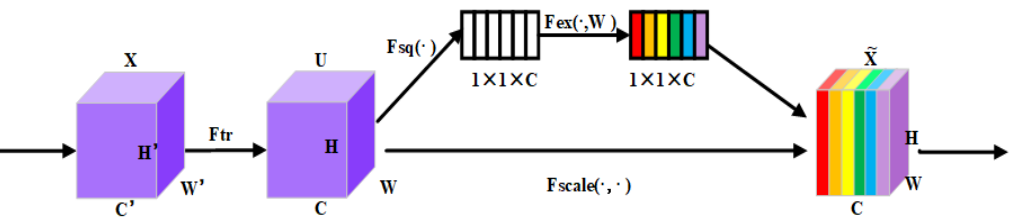
Figure 5. Details of the Squeeze-and-Excitation operation. H’, W’, C’, H, W, and C are the height, width, and channel number of feature map X, U, and (cid:101) X , respectively, F tr represents traditional con- volution operation, F sq ( · ) represents squeezing operation, F ex ( · , W ) represents excitation operation, F scale ( · , · ) represents scale operation.